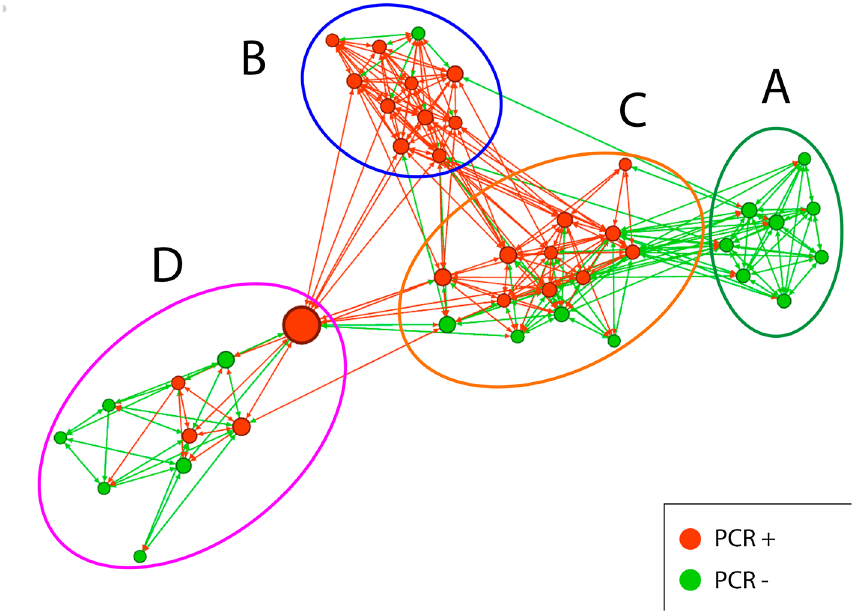
Figure 1. Subgroups Girvan–Newmann PCR result [created with Gephi 0.92 (https:// gephi. org/)].